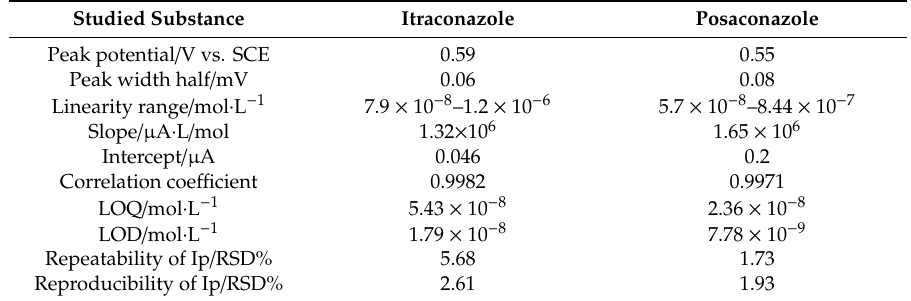
Table 1. Quantitative determination of itraconazole and posaconazole on the BDD electrode using the SWV method.